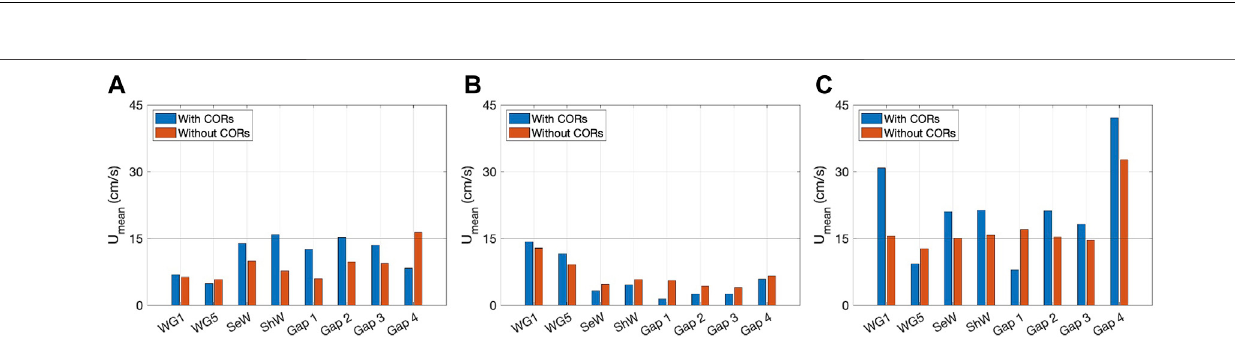
Figure 11 . Wave attenuation is calculated by the wave height difference at both sides of COR 5. For the MSL in Figure 11A , since COR 5 is emergent for the unsustainable design with limited